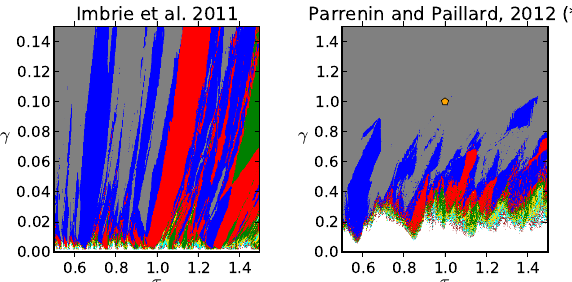
Fig. 17. As Fig. 16 for (left) the I11 model, but with a zoom on the x axis, and (right) for a slightly modified version of the PP12 model, in which the transition between deglacial and glacial states is also controlled by ice volume, as opposed to the original PP12